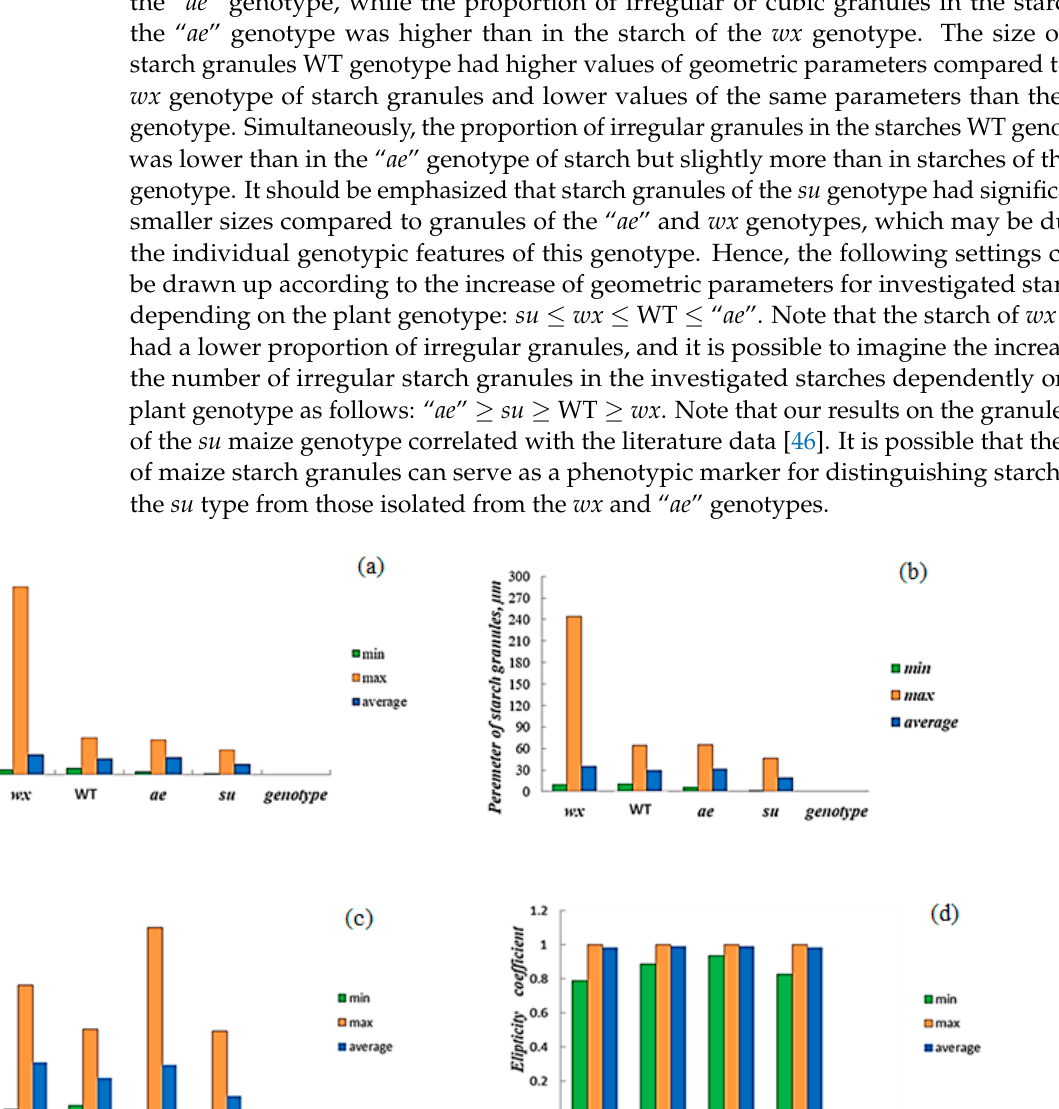
Figure 4. Examples of the granulometric data: diameter ( a ), perimeter ( b ), area ( c ), ellipticity coef- ficient ( d ), and proportion of elliptical forms ( e ) of starch granules from maize plants of different genotypes. 3.3. X-ray Diffraction Figure 5 shows the XRD patterns of maize starches of various genotypes. As known, A-polymorphous structure is characteristic of waxy ( wx -genotype) and normal maize (transitional from wx to ae genotype) starches [11] and B-polymorphous structure—for high-amylose maize starches ( ae -genotype) [45,46]. It can be seen that all investigated starches showed peaks at 2 θ ≈ 15, 17, 18, and 23°, typical for A-type polymorphous structures. Hence, our investigated starches have an A-type polymorphous structure correlated with literature data for waxy, normal, and sugar maize starches [11,46,47]. The intensity of the peak at 2 θ ≈ 20° was higher in the case of starches of WT and su genotypes than for starches of wx- genotype (Figure 5, curve 2–5). Probably this could be accounted for by the formation of the amylose V h ordered structure in amylose-rich starches [36,46,48]. The crystallinities C of starch samples calculated with Equation (1) are de- picted in Table 2. According to these results, the crystallinity of a waxy starch (variety Mais agestano, 0% amylose content, wx genotype) was essentially higher (C = 41%) than for starch samples with 17–38% amylose content (varieties Luch, Baksanskaya sakharnaya, Gornaya chechenskaya, White Flint with genotypes wt , su , and ae , corre-